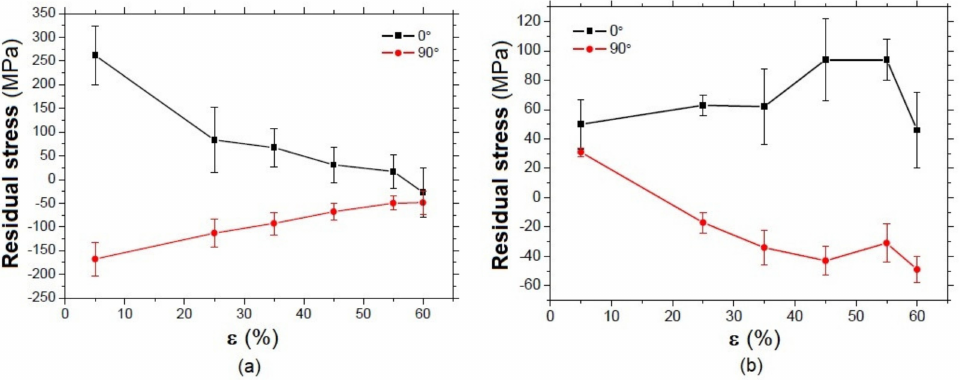
Figure 7. Depth profiles of residual stresses. ( a ) martensite phase, ( b ) austenite phase.